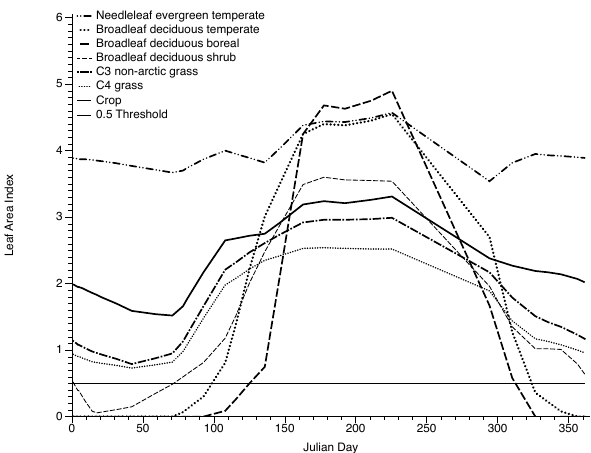
Fig. 1. Annual leaf area index (LAI) cycle for several plant func- tional types (PFTs) that are simulated in the CLM. The 0.5-LAI threshold (grey horizontal line), above which O 3 accumulates, demonstrates that O 3 accumulates at most times when LAI is pos- itive, but minimizes uptake when LAI does not mathematically reach 0 when it should equal 0, particularly relevant in the broadleaf deciduous temperate and boreal